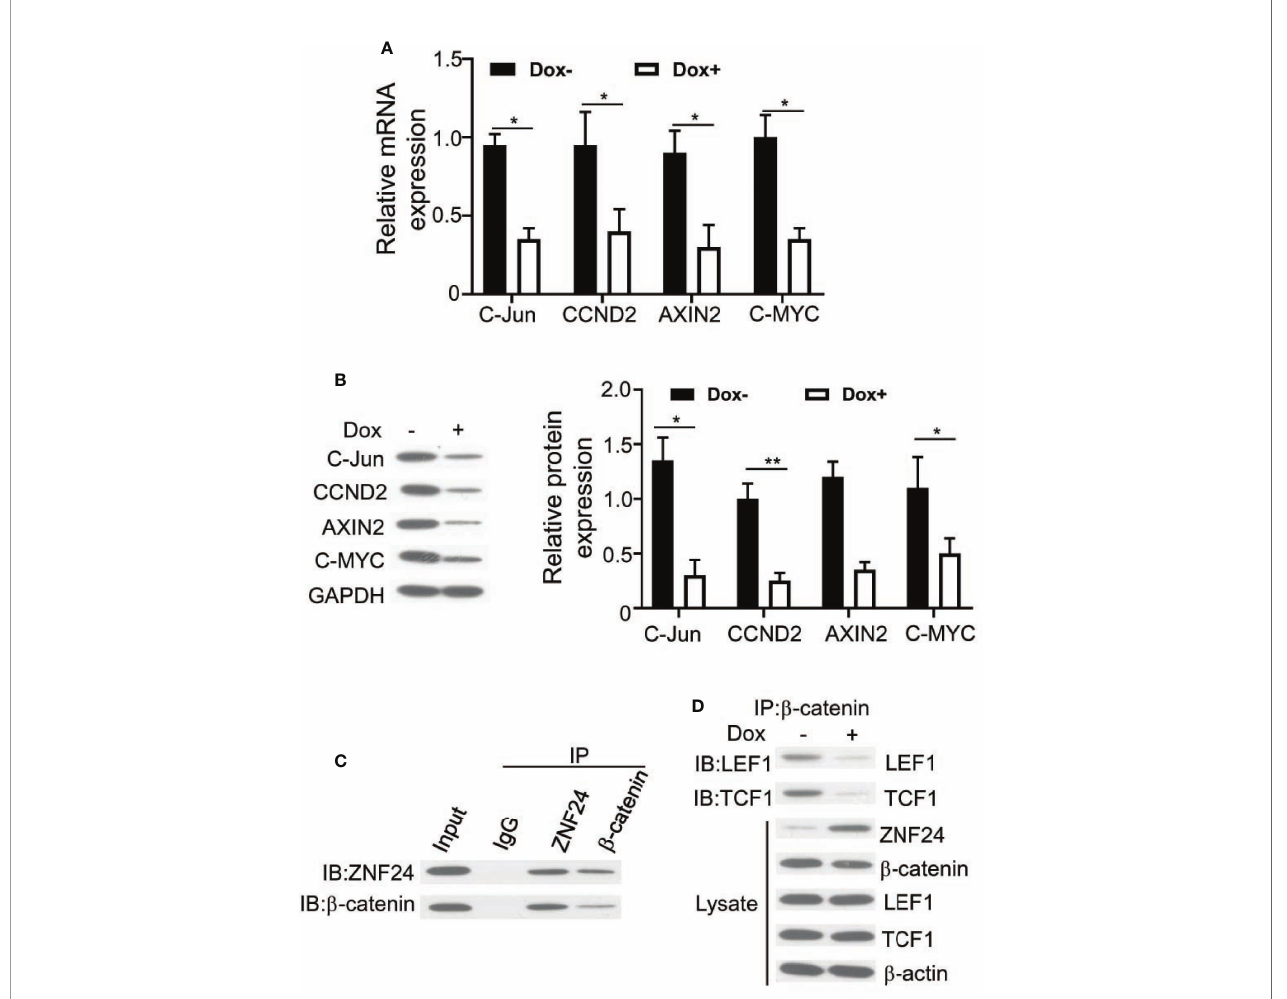
FIGURE 4 | ZNF24 inhibits the activation of Wnt signaling pathway in BCPAPi cells by competitively binding b -catenin. (A) ZNF24 inhibits Wnt signaling pathway traget genes mRNA expression. BCPAPi cells (2 × 10 5 ) were subjected to 48 h of 1 µg/ml DOX treatment or not, then qPCR was conducted to extract total RNA; (B) Wnt signaling pathway traget genes protein expression level detection by Western Blot assay of BCPAPi cells treated without or with DOX (1 µg/ml), indicated antibodies were added during Western Blot assay. (C) Endogenous ZNF24 is associated with b -catenin within the BCPAPi cell line. CoIP assays were carried out using anti- b -catenin or anti-ZNF24, then immunoblots that contained speci fi c antibodies were used to analyze whole-cell lysate and immunoprecipitates (input). (D) ZNF24 diminish the interaction between b -catenin and TCF1 or LEF1. 2.5 g plasmids were used to transfect 293T cells (2 × 10 6 ). CoIP and immunoblot assays were carried out using speci fi c antibodies. Values are obtained from 3 independent assays, while unpaired t-test was used for analysis. Error bars=SD. *P < 0.05, **P <